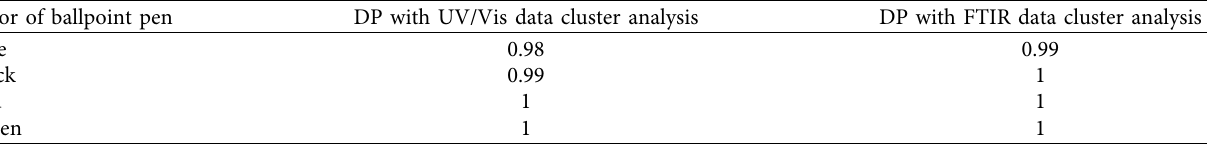
Table 5: DP calculations of ballpoint pen inks with cluster analysis. Color of ballpoint pen DP with UV/Vis data cluster analysis DP with FTIR data cluster analysis Blue Black